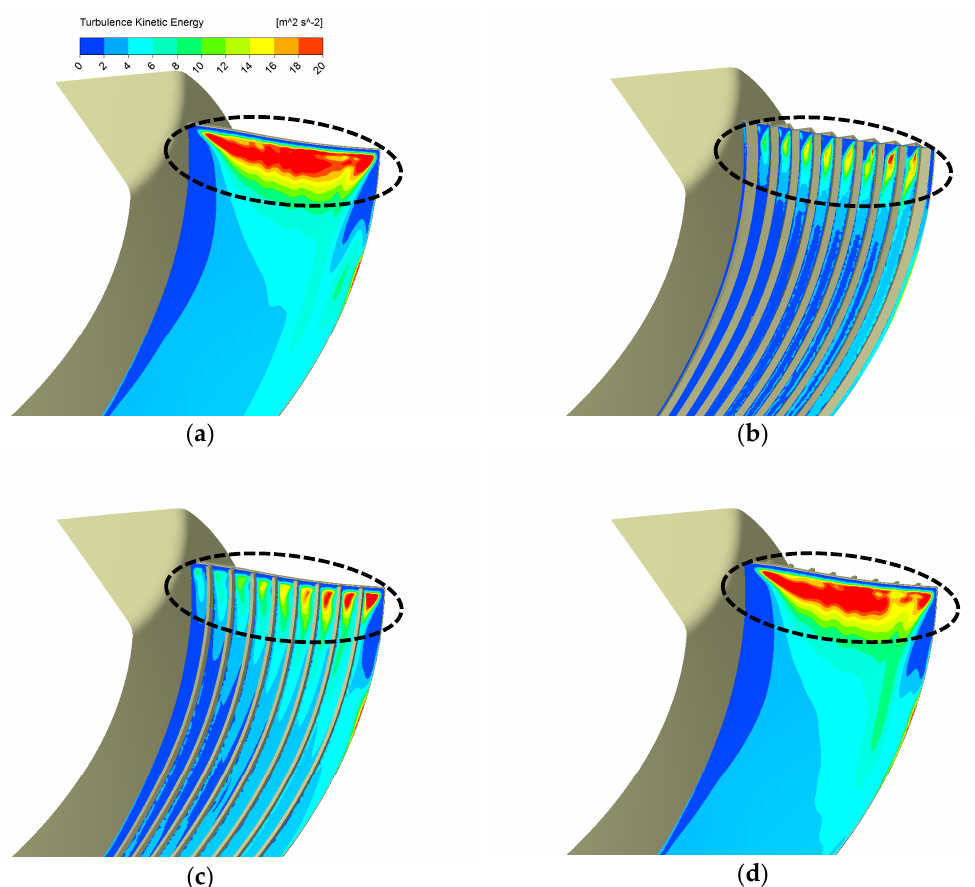
Figure 10. TKE contours on Off_Suc_1 mm of different blade forms: ( a ) Basic, ( b ) Wavy_N9_H3, ( c ) Rib_N9_H4.2, ( d ) Rib_N9_H4.2_Pressure.